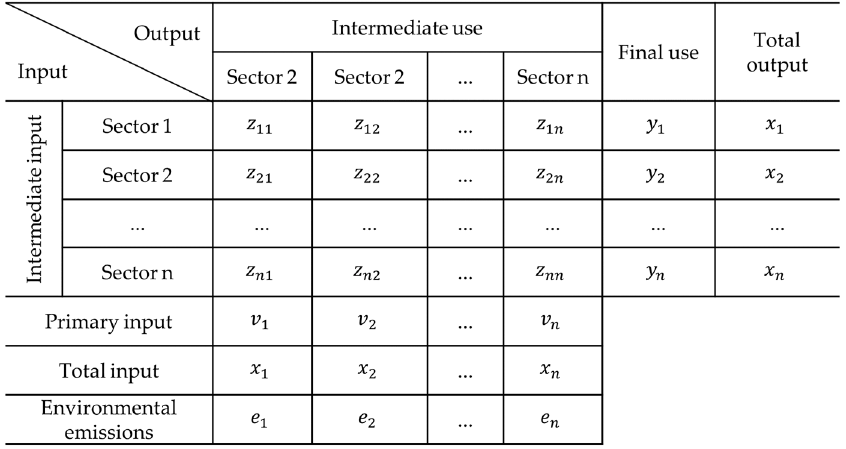
Figure 6. A simplified environmental extended input-output table.